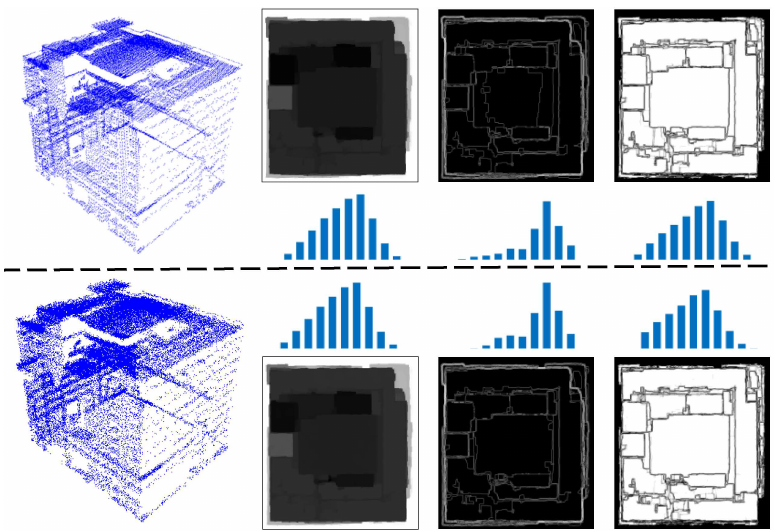
Figure 9. Demonstration of noise insensitivity. ( Top ): point cloud encoding results; ( Bottom ): encoding results of a point cloud with Gaussian noise